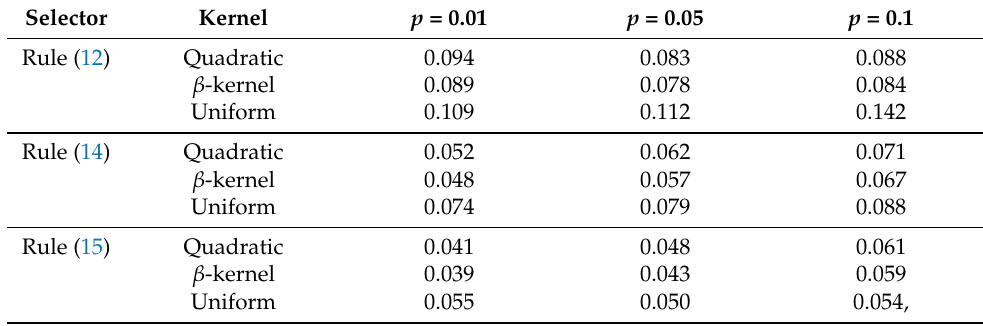
Table 1. Comparison of ASE-error using different kernels and smoothing parameters.